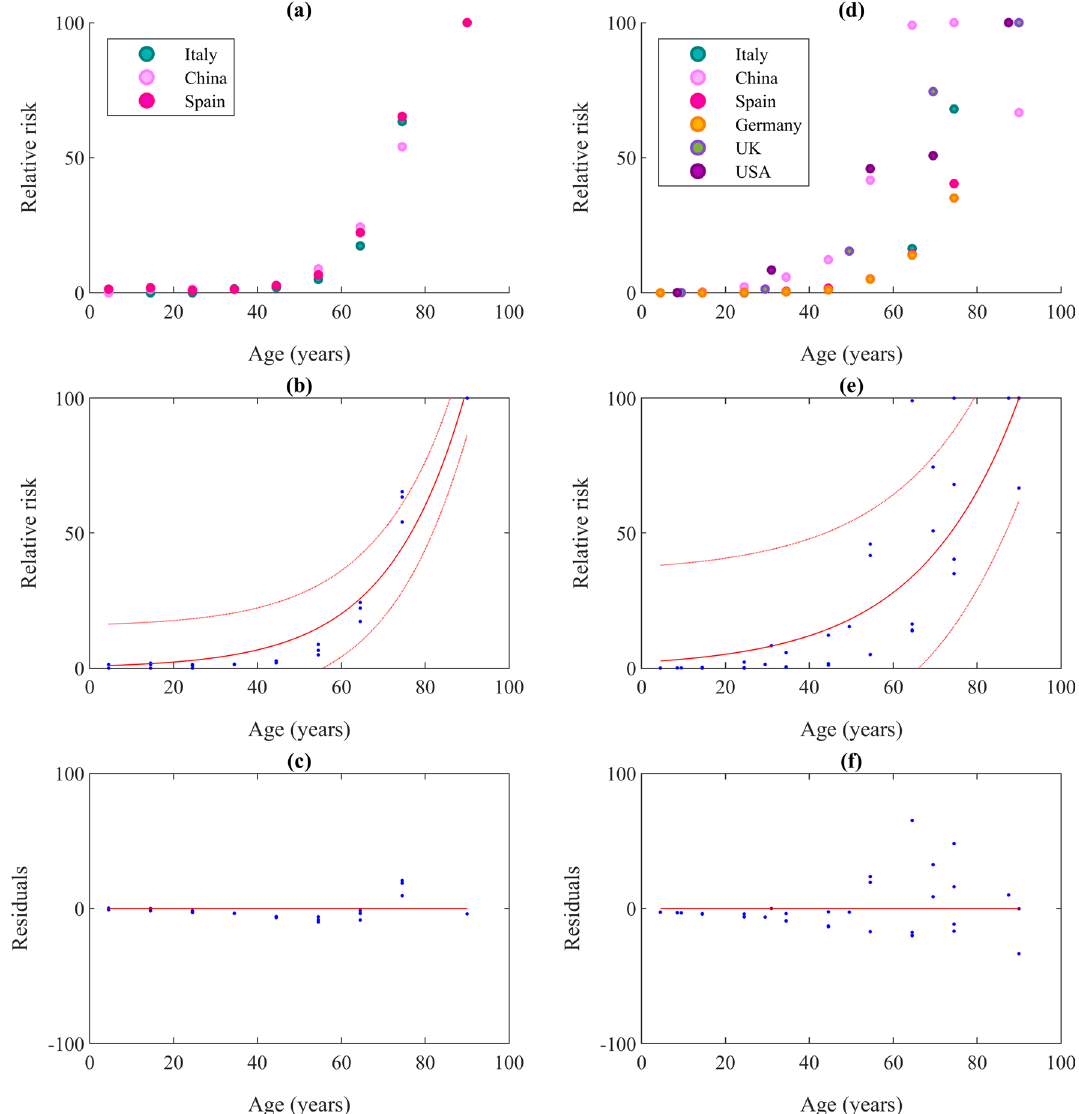
Figure 7. Correlation of recorded deaths and age: ( a ) normalized fatality percentages of cases of respective age group; ( b ) exponential curve fit to data of ‘a’ with 95% confidence boundaries; ( c ) corresponding residuals; ( d ) normalized fatality percentage of total fatality reported; ( e ) exponential curve fit to data of ‘d’ with 95% confidence boundaries; and ( f ) corresponding